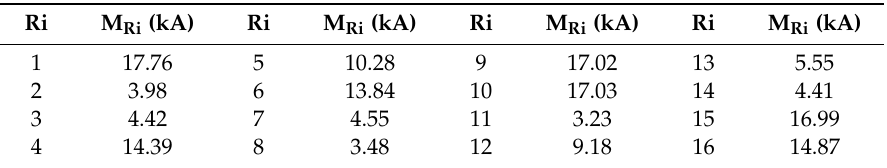
Table 9. Mean value of each relay’s maximum fault current.